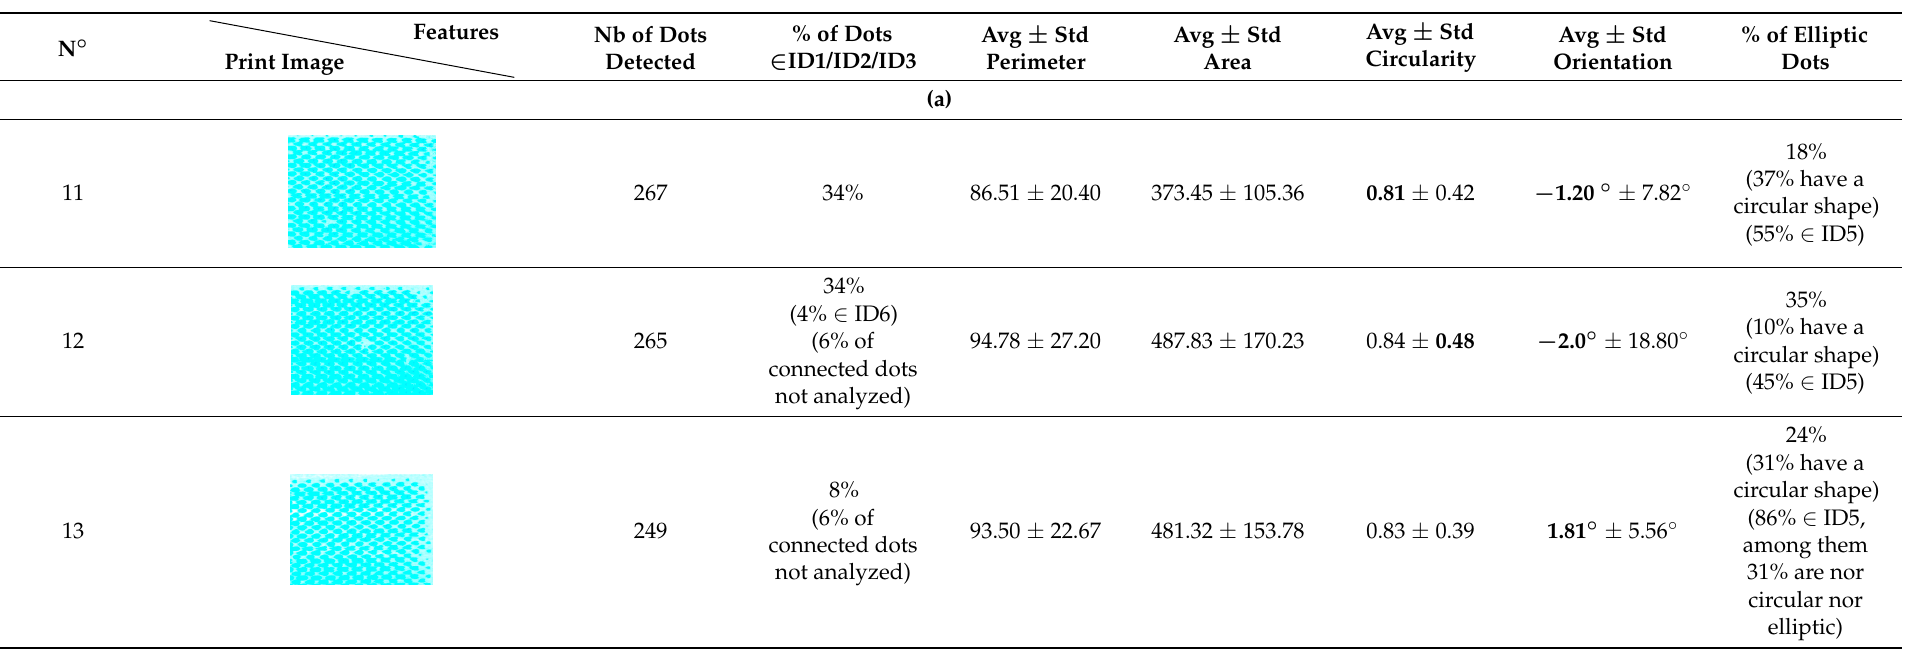
Figure 14. ( a ) Magenta dots with 95% of doughnuts oriented in the print direction; ( b ) Magenta dots with 85% of doughnuts oriented in the print direction. Orientation of the doughnuts vs. print direc- tion. Table 2. ( a ) Statistical values computed for print cyan dots. The most significant values are highlighted in bold. ( b ) Statistical values computed for reprint cyan dots. The most significant values are in bold.